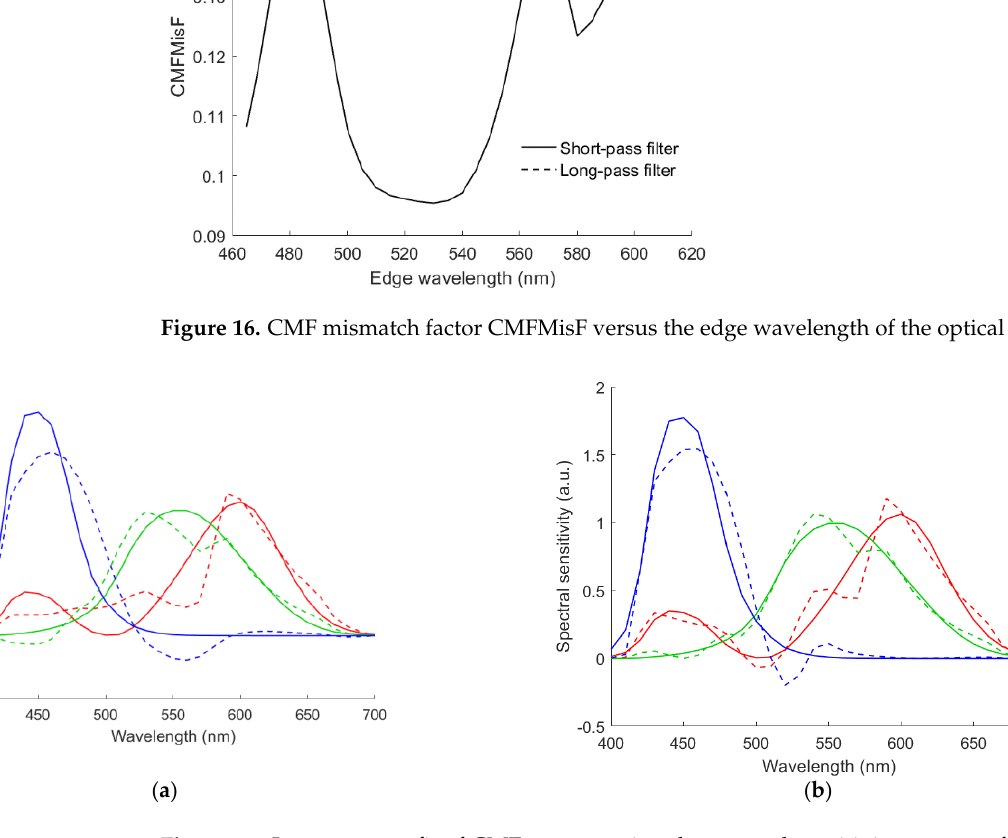
Figure 17. Least squares fit of CMF vectors using the spectral sensitivity vectors of ( a ) the RGBF camera and ( b ) the optimized RGBS camera with the 528 nm short-pass optical filter. The CMFs x , y and z are shown in red, green and blue, respectively. Solid and dash lines show the CMFs and least squares fits,